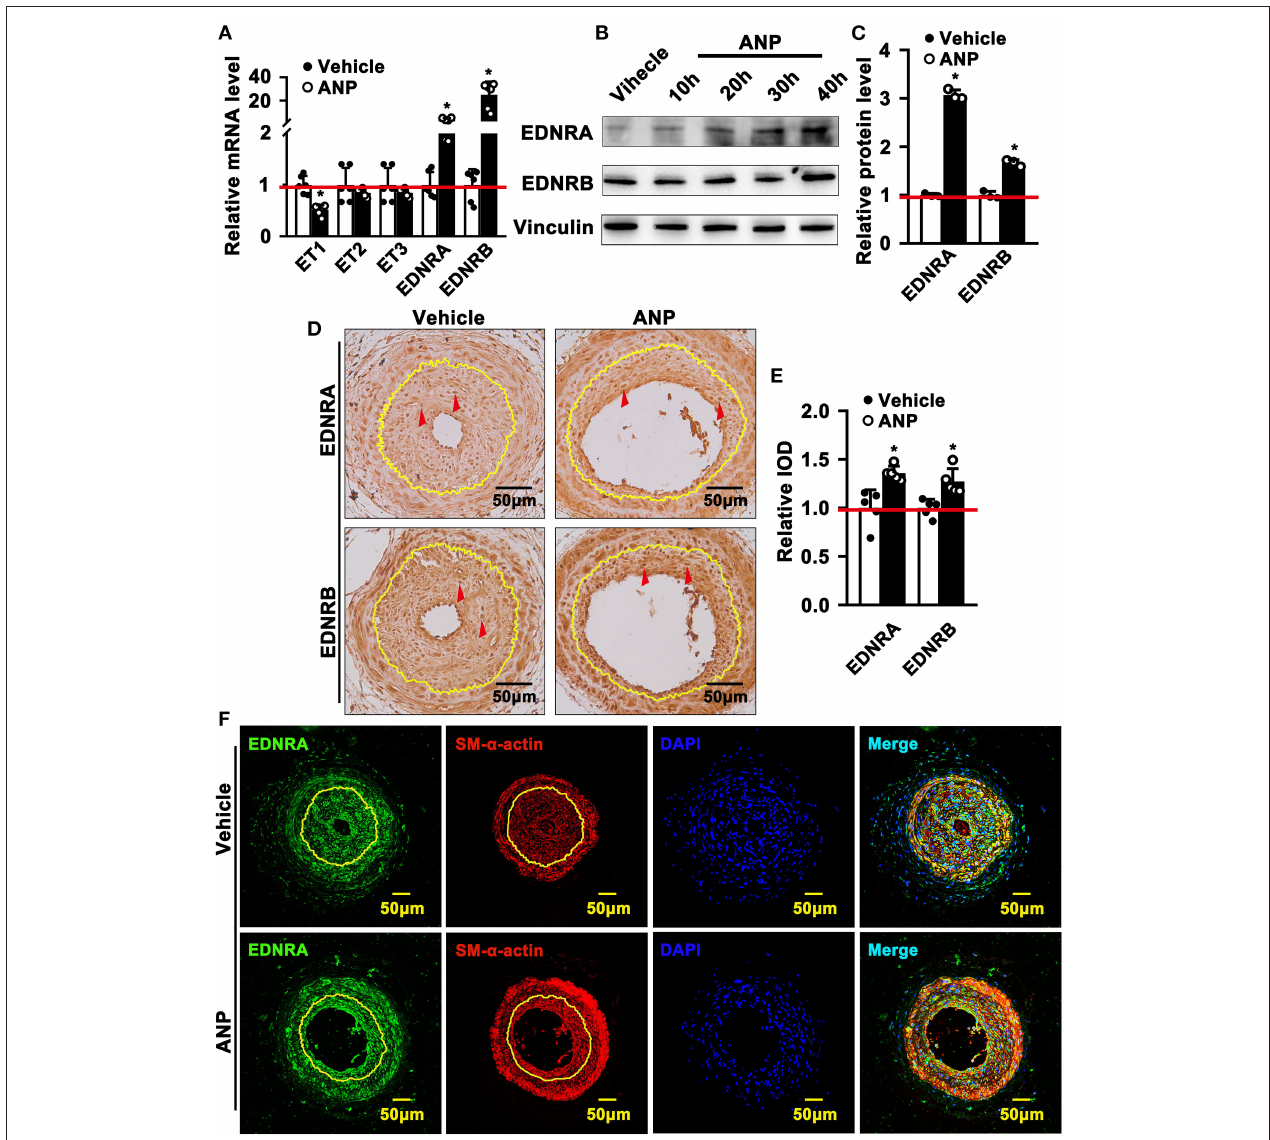
FIGURE 5 | Andrographolide activates endothelin family response to vascular injury stress. (A) Rat SMCs were treated with Andrographolide (5 µ M) for 30h. Real-time PCR was performed to detect the mRNA level of the endothelin family ( n = 6). (B) Western blot was performed to determine the expression of EDNRA and EDNRB in SMCs after Andrographolide (5 µ M) treatment for different time points, and the quantification data are shown (C) ( n = 3). (D) Immunohistochemistry staining was performed to detect the expression of EDNRA and EDNRB in the completely ligated carotid arteries. (E) The relative protein levels were quantified by Average Optical Density (Integrated option density/Area) using Image J software ( n = 5). (F) Immunofluorescence staining was used to evaluate the expression of EDNRA ligated left carotid arteries. The analysis data are expressed as means ± SEM. * P <